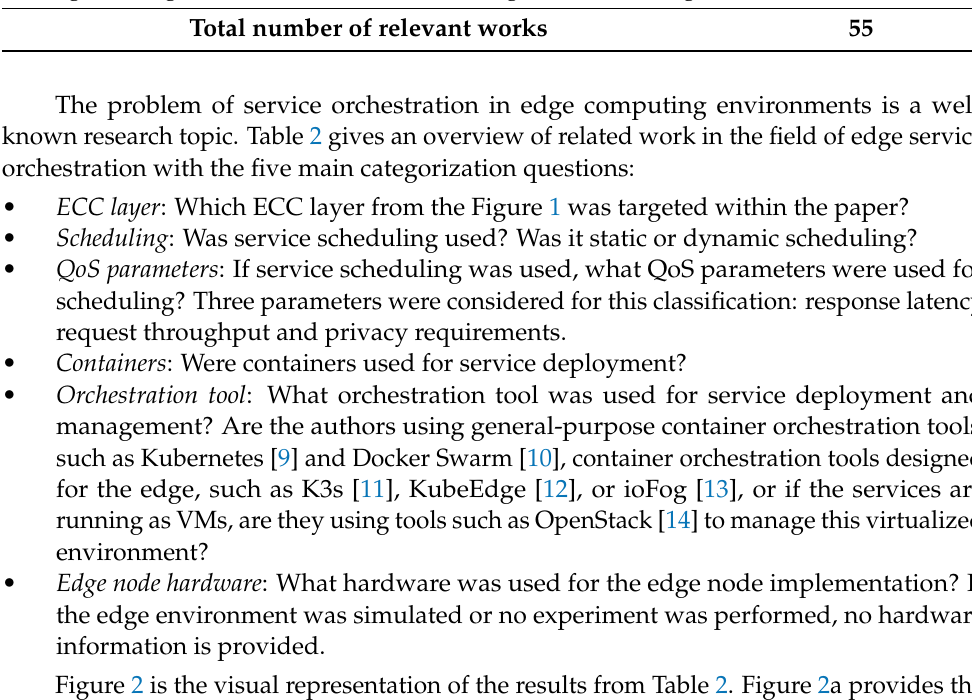
Table 1. Related work search queries. Query Reference Count (edge OR fog) AND orchestration 24 (edge OR fog) AND container 17 (edge OR fog) AND scheduling 11 (edge OR fog) AND serverless 7 (edge OR fog) AND